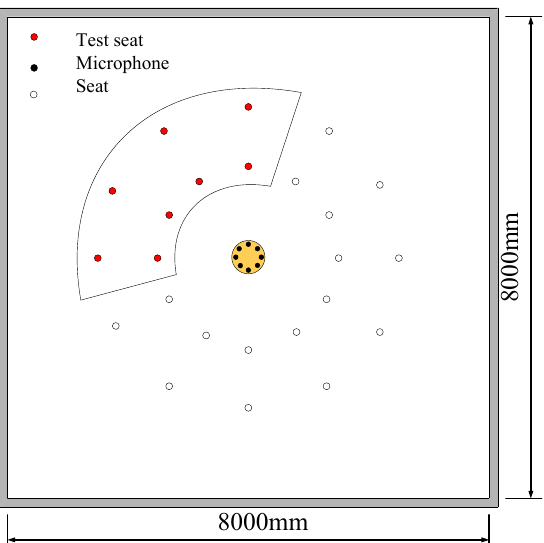
Figure 3. The locations of the microphone array and the seats in the simulations.